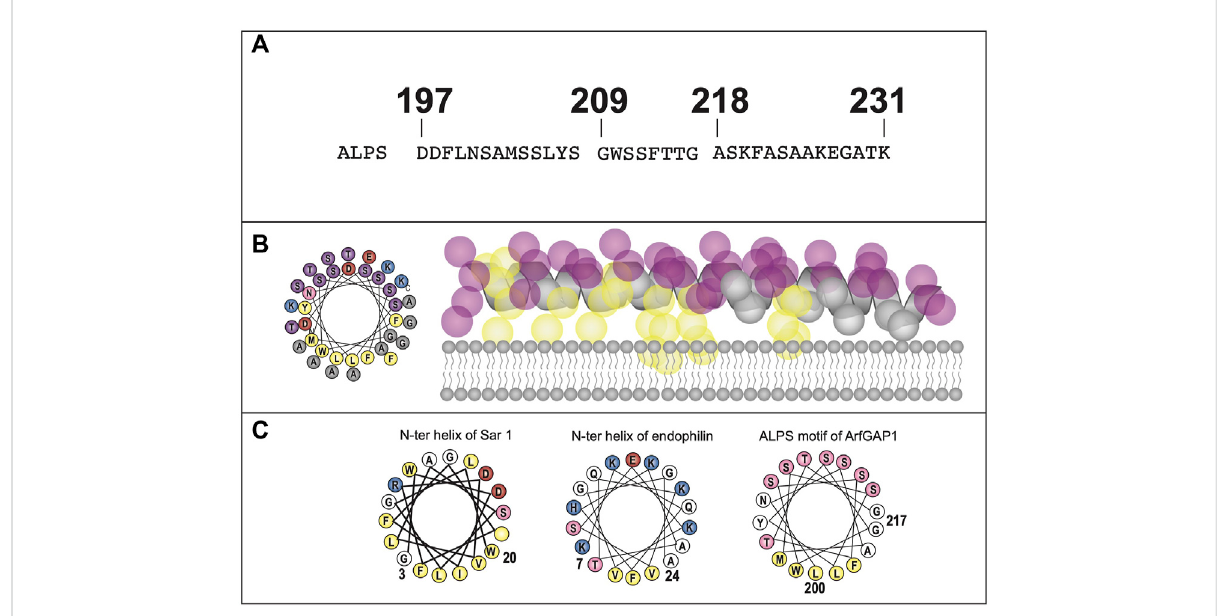
FIGURE 6 Overview of Membrane Shaping/Sensing APHs. (A). Prototypical APH (Amphipathic-Lipid-Packing-Sensor/ALPS) domain from ArfGAP1 is shown in single amino acid code and as a helical wheel diagram (yellow: bulky hydrophobic residues, purple: serines and threonines, gray: glycines and alanines, blue: positively charge residues, red: negatively charged residues) (Modi fi ed from Reference (Drin et al., 2007)). The helical wheel was generated using HELIQUEST software (Gautier et al., 2008). (B). An alternative atomistic view, demonstrating the backbone arrangement of hydrophobic (yellow) and hydrophilic (magenta) amino acid residues is also shown). Notice the facial separation of hydrophobic and hydrophilic residues which allows for the APH to either sense or associate with membrane lipids (Modi fi ed from Reference (Van Hilten et al., 2020)). (C). Similar helical wheel diagrams for APHs from other proteins that exhibit organelle membrane-speci fi c localization are shown: Sar1 (ER membrane), endophilin 1 (plasma membrane) and ArfGAP1 (Golgi membrane) (yellow: bulky hydrophobic residues, pink: serines and threonines, white: glycines andalanines,blue:positivelychargeresidues,red:negativelychargedresidues).IthasbeenpostulatedthatAPHsareadaptedtodifferentmembranes and can either induce (Sar1, endophilin) or sense (ArfGAP1) membrane curvature, depending upon the size of the hydrophobic face as well as the charge distribution within the hydrophilic face (Antonny, 2006). However, no speci fi c amino acid sequence homology has been found to delineate these differences, suggesting that a combination of amino acid composition, spacing, and packing as well as membrane con fi guration may all play a part in such membrane